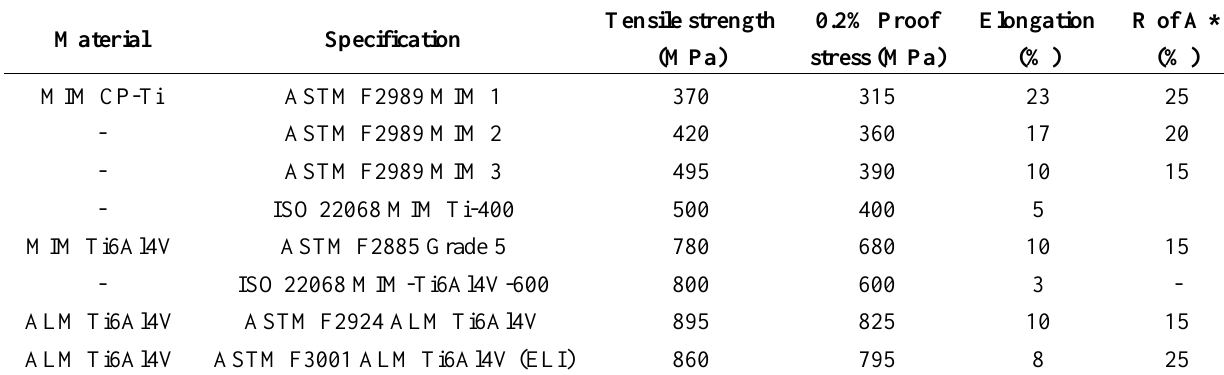
Table 3. Mechanical properties of CP-Ti MIM, Ti-64 MIM and